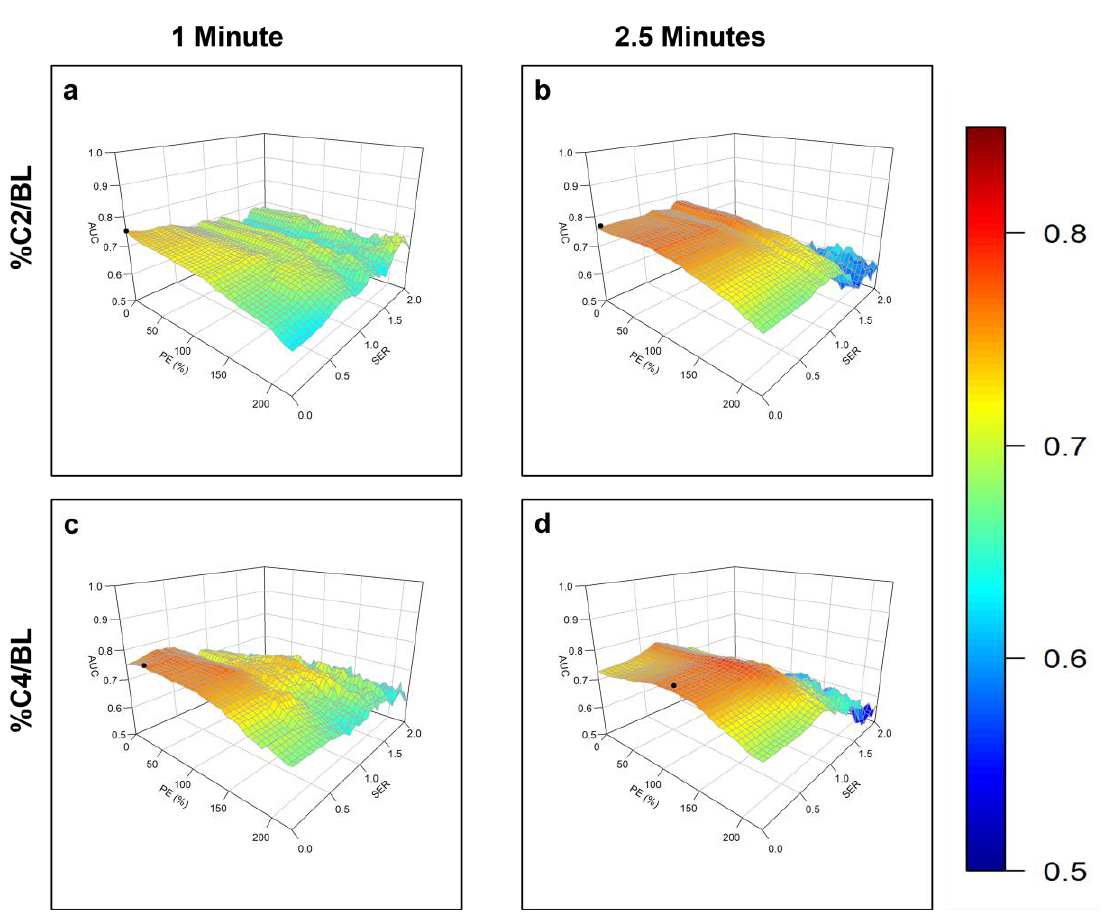
Figure 4. Plots of the area under the receiver operating characteristic curve (AUC) for response prediction as a function of the percentage enhancement (PE) and signal enhancement ratio (SER) used to calculate the functional tumor volume for relative changes between baseline and after 2 cycles of neoadjuvant systemic therapy (C2) (%C2/BL), and between baseline and after 4 cycles of neoadjuvant systemic therapy (C4) (%C4/BL): ( a ) %C2/BL per the early phase at 1 min, ( b ) %C2/BL per the early phase at 2.5 min, ( c ) %C4/BL per the early phase at 1 min, and ( d ) %C4/BL per the early phase at 2.5 min after contrast agent injection. In each case, the PE – SER combination with maximum AUC (black circle) was selected as the optimal threshold.